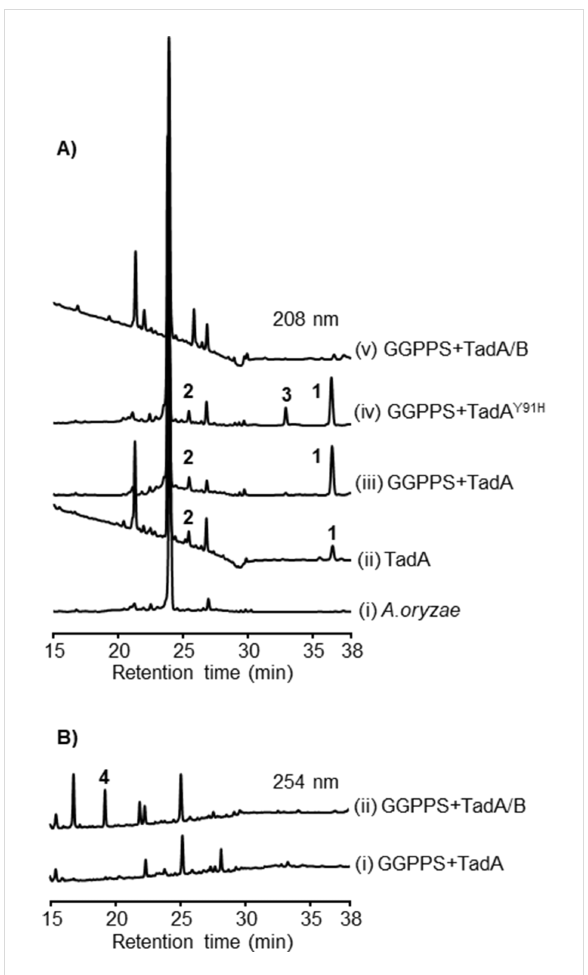
Figure 3: HPLC–MS analysis of mycelial extracts from A. oryzae NSAR1 transformants. A) The HPLC profiles monitored at 208 nm. B) The HPLC profiles monitored at 254